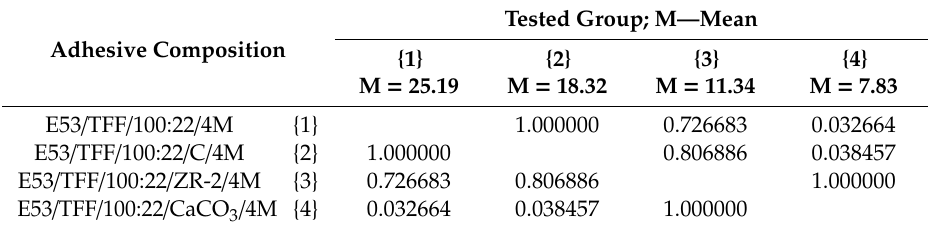
Table 12. The Kruskal–Wallis rank test results of the strength of the adhesive compositions from the E53 / TFF / 4 month